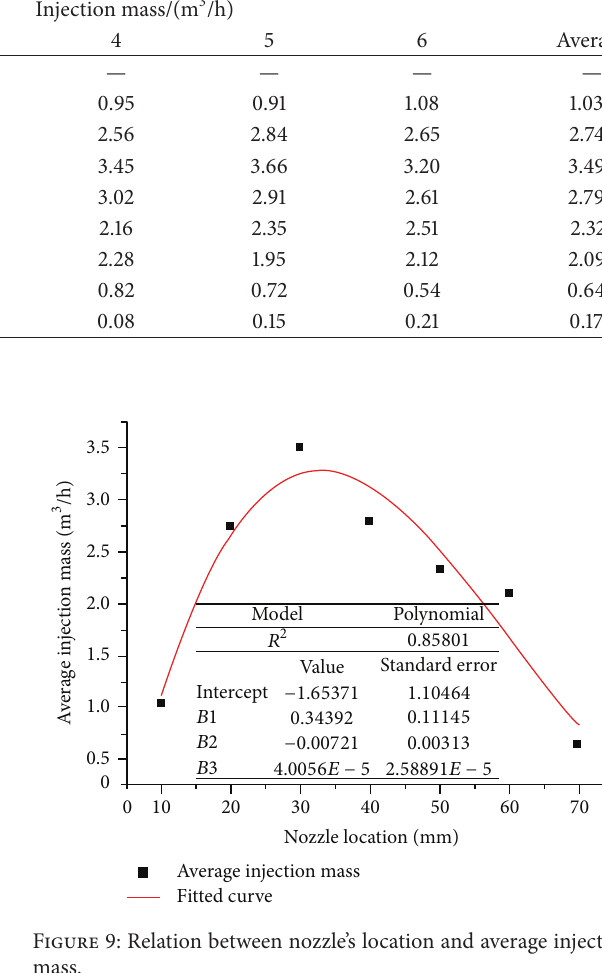
Figure 8: Gas-solid injector test-bed.